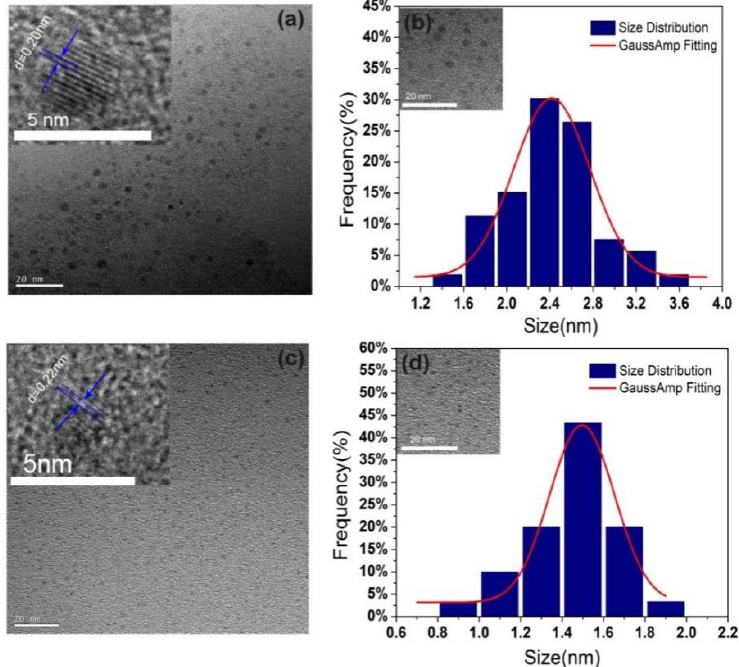
Figure 8. ( a , c ) TEM and HRTEM (the insert) images of CQDs (24 h) and CQDs (48 h); ( b , d ) The size distribution and local enlarged TEM image (inset) of the CQDs (24 h) and CQDs (48 h).